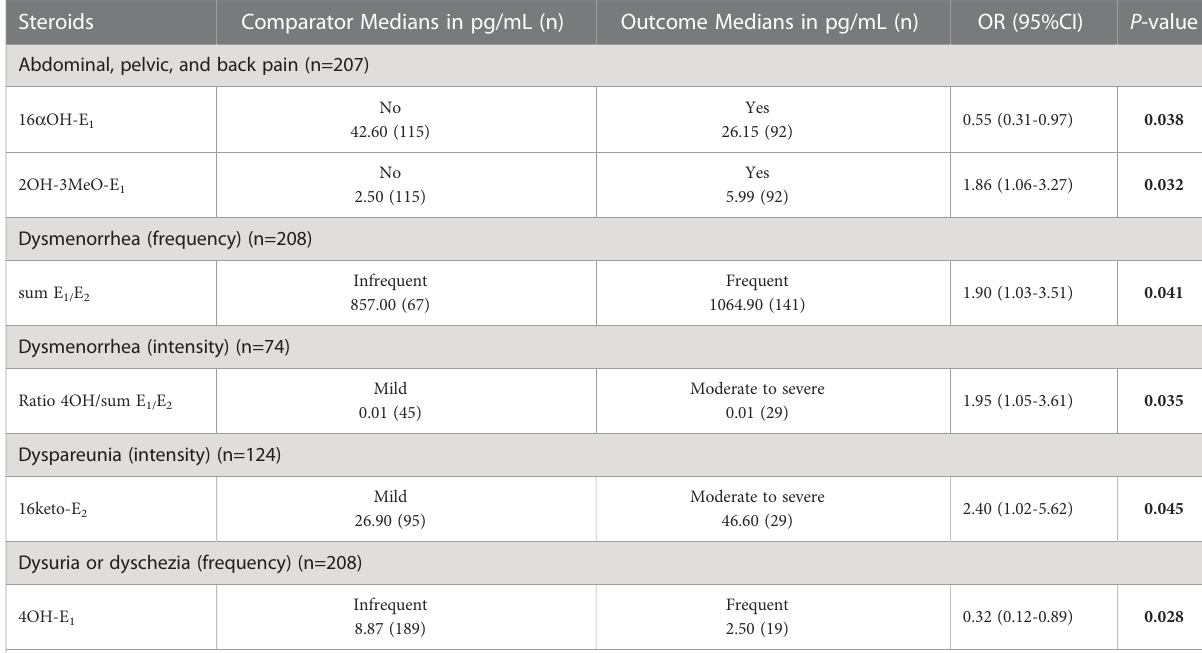
TABLE 5 Signi fi cant associations between pain and steroid levels in EM cases (n=209).